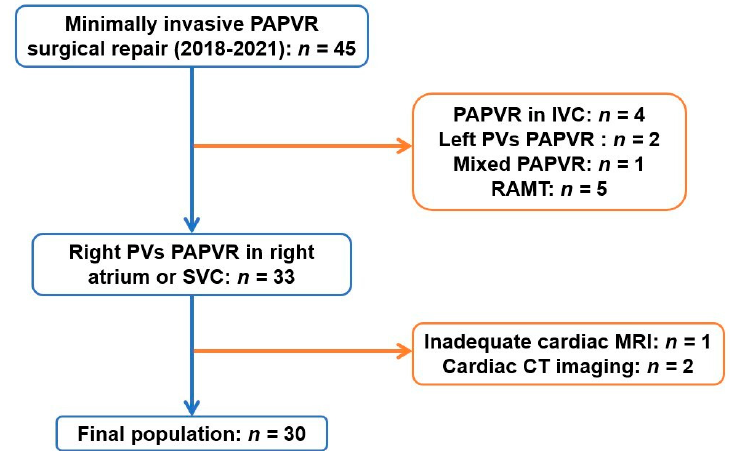
Figure 1. Flowchart showing the inclusion and exclusion criteria during the selection of the study population. CT: computed tomography; IVC: inferior vena cava; MRI: magnetic resonance imaging; PAPVR: partial anomalous pulmonary venous return; RAMT: right anterior minithoracotomy; SVC: superior vena